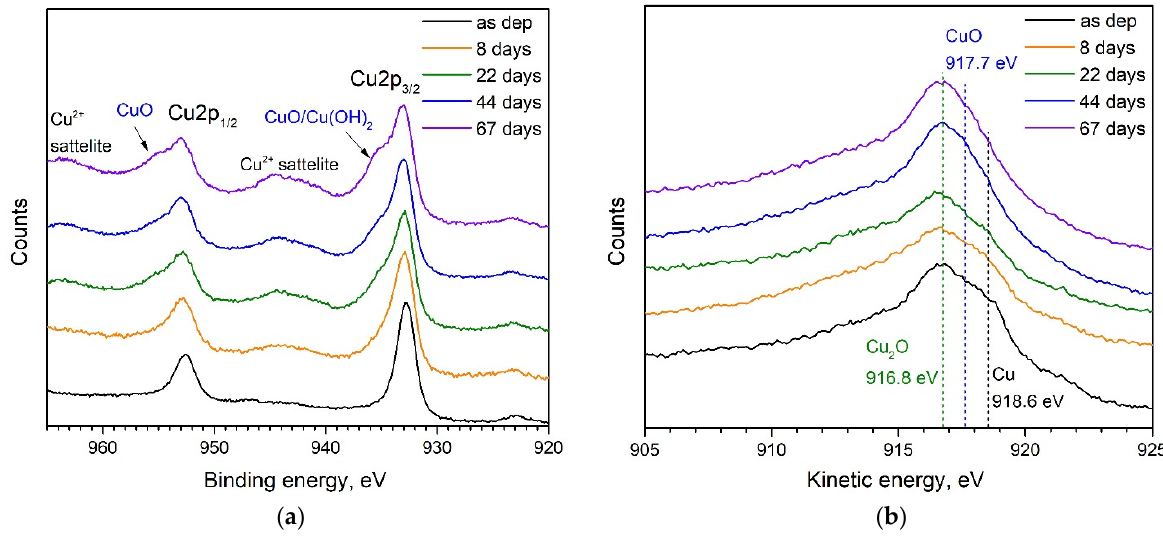
Figure 3. Time evolution of ( a ) XPS and ( b ) AES spectra of Cu NPs kept in ambient conditions. Characteristic peaks related to Cu2p 3/2 and Cu2p 1/2 states, Cu 2+ satellites as well as bands related to Cu(OH) 2 and Cu(II) oxide are indicated in panel ( a ). Vertical dashed lines in panel ( b ) show the energies for Cu(I) and Cu(II) oxides as well as for metallic Cu.